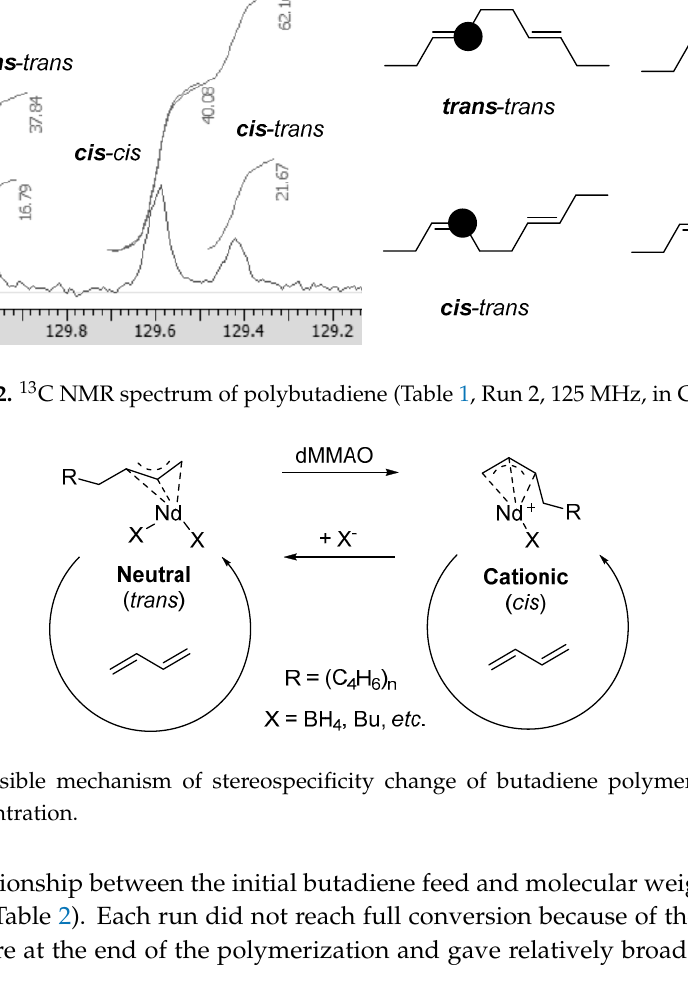
Figure 2. 13 C NMR spectrum of polybutadiene (Table 1, Run 2, 125 MHz, in CDCl 3 ).